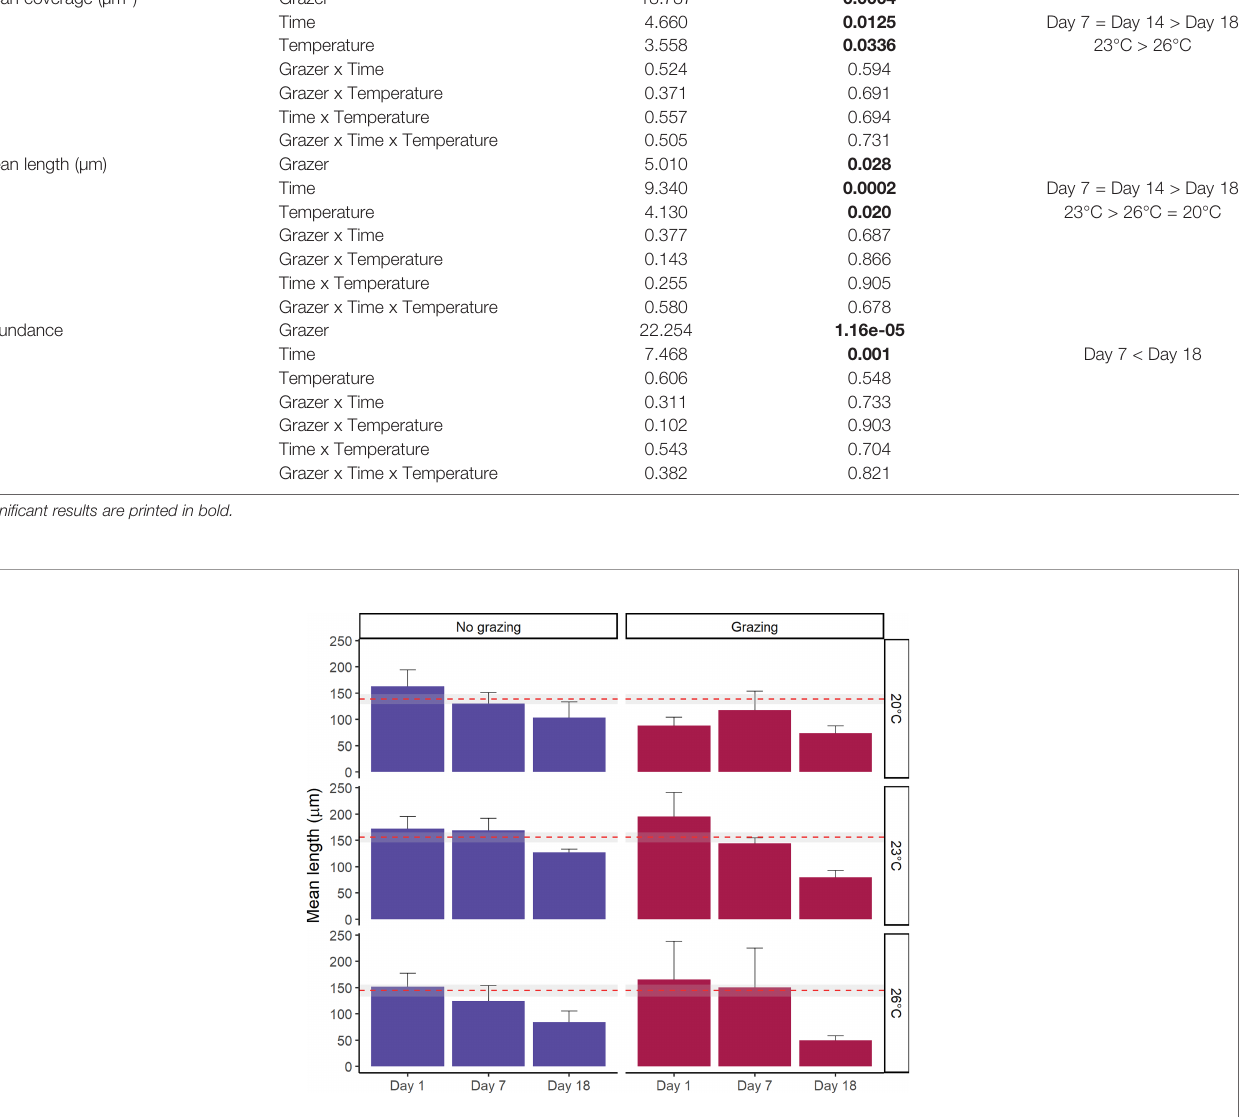
FIGURE 3 | Mean length of Ecklonia radiata gametophytes (µm) at three temperatures (20°C, 23°C and 26°C) tracked over an 18-day period after exposure to grazing. Error bars represent SE, n = 5. The red dashed line represents the mean length of each temperature treatment prior to grazer exposure (i.e. baseline length data), with the grey area denoting the 95% con fi dence